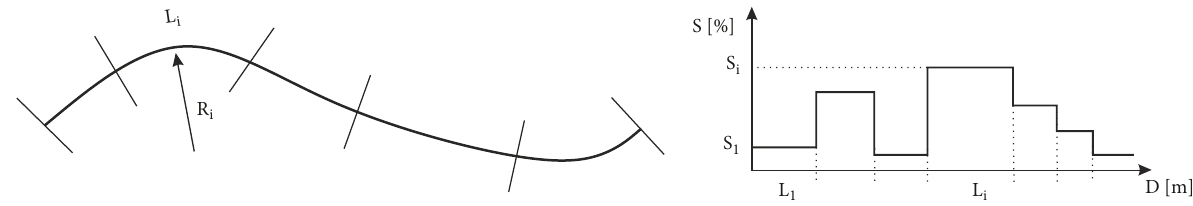
Figure 5: Driving path and its inclination